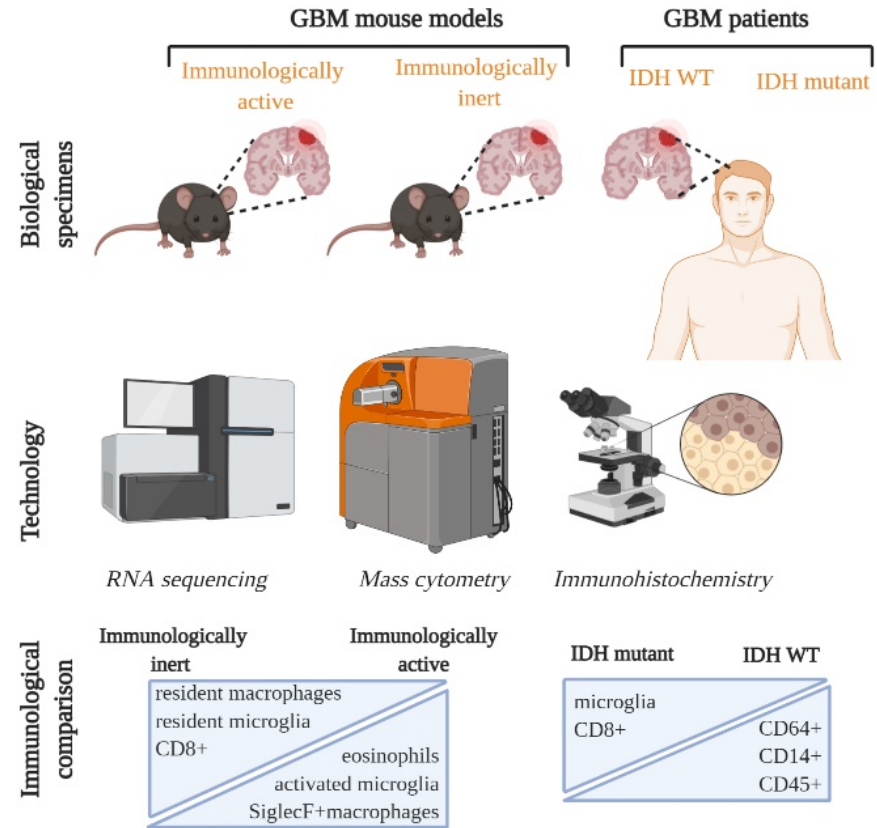
Figure 1. Single cell characterization of Immune landscape in GBM mouse models and patients. GBM mouse models were divided into immunologically active and inert based on RNA sequencing and GBM patients were categorized into 2 groups based on their IDH (isocitrate dehydrogenase) status: IDH WT and IDH mutant. Combining technological advances, such as RNA sequencing, CYTOF and immunohistochemistry, has allowed multi-parametric mapping of previously unexplored immune cell subsets. Immunologically inert mouse models and IDH mutant GBM patient tumors have numerous microglia and CD8+ populations. On the other hand, immunologically active and IDH WT patient GBMs are characterized by more leukocytes and activated microglia. GBM: glioblastoma; IDH: isocitrate dehydrogenase.